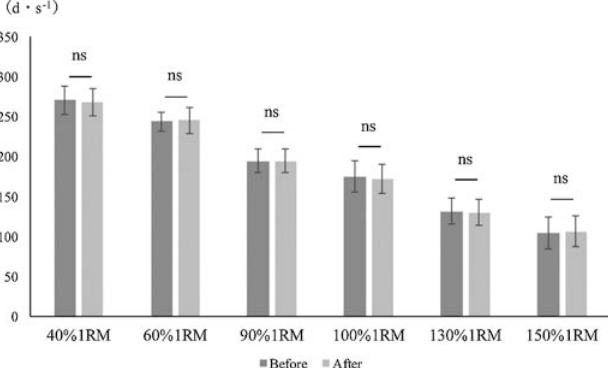
Figure 2 Comparison of peak angular velocity before and after modification of the leg extension machine.